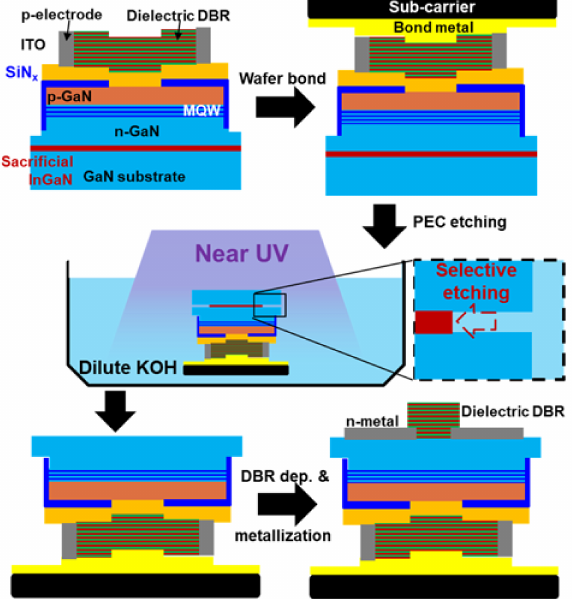
Figure 9. Schematic process of dual-type VCSEL via